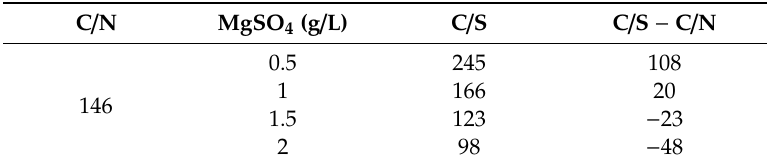
Table 2. Di ff erent MgSO 4 concentrations and their calculated carbon to nitrogen ratio (C / N) and carbon to sulfur ratio (C / S). C / N MgSO 4 (g /